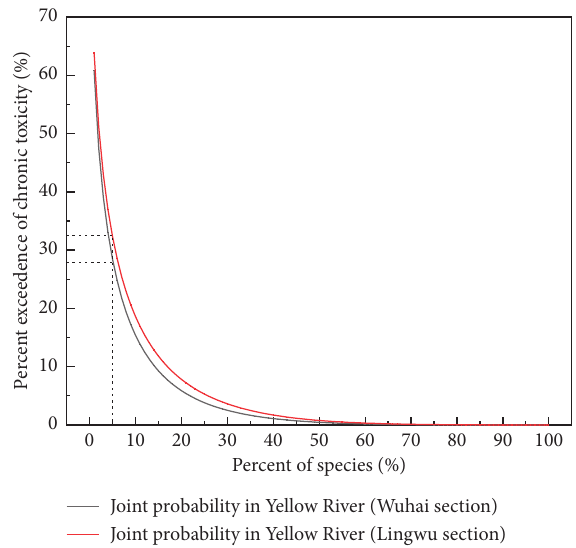
Figure 3: JPC of PAHs in surface water of the Yellow